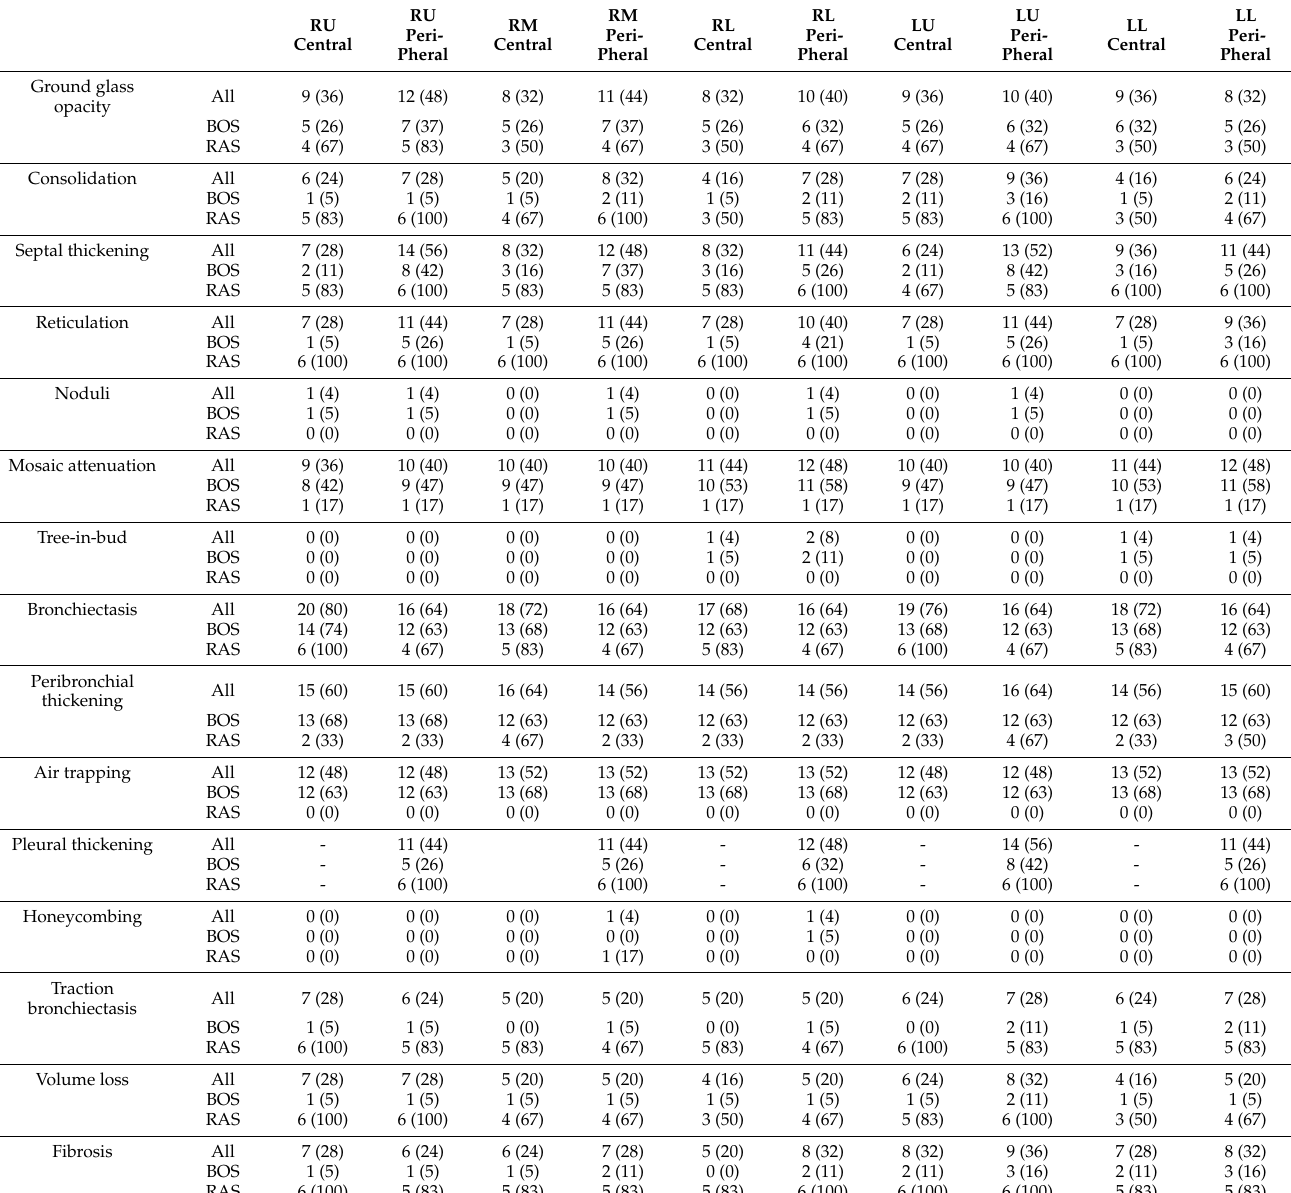
Table 3. Specific HRCT findings according to HRCT areas and stratified corresponding to all, BOS, and RAS